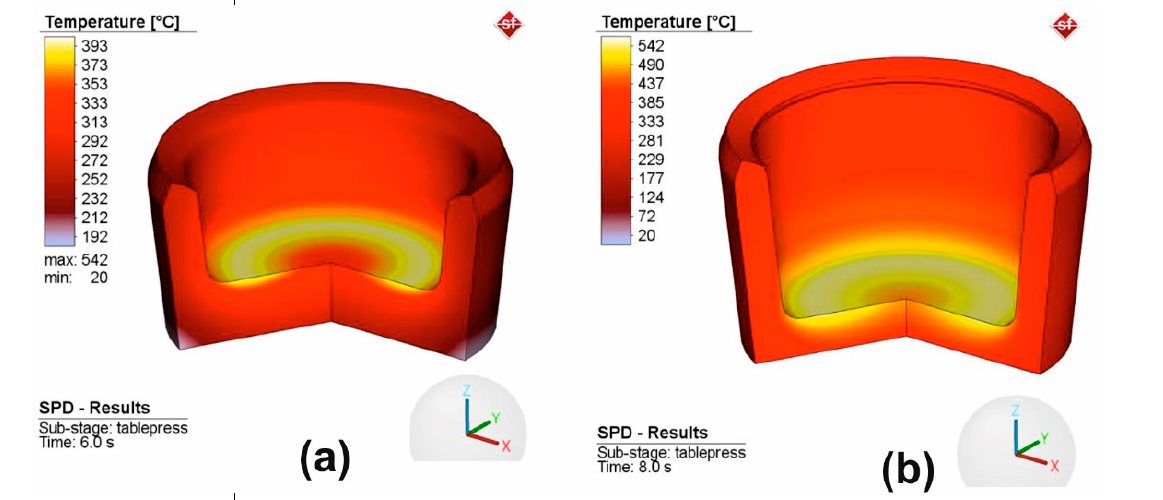
Figure 7. Temperature pro fi le at two moments in time, 6 s ( a ) and 8 s ( b ) from the SPD beginning. The convection and radiation phenomena are insigni fi cant in the Bridgman cell. The maximum temperature value (542 °C) was validated by the experimental data (Figure 5).